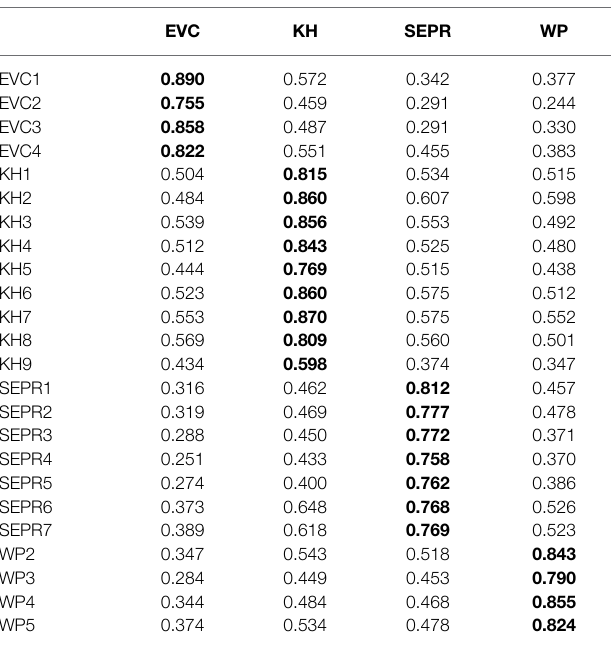
TABLE 3 | Cross-loading.